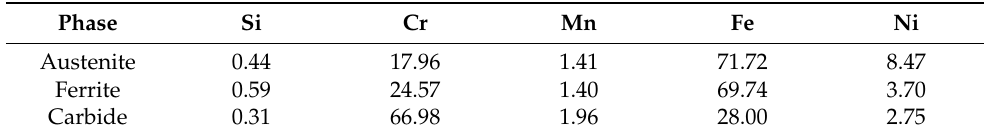
Table 2. Chemical composition of major elements of the phases measured by TEM EDS in the AISI 304L stainless steel heat treated at 600 ◦ C for four hours (in wt.%).